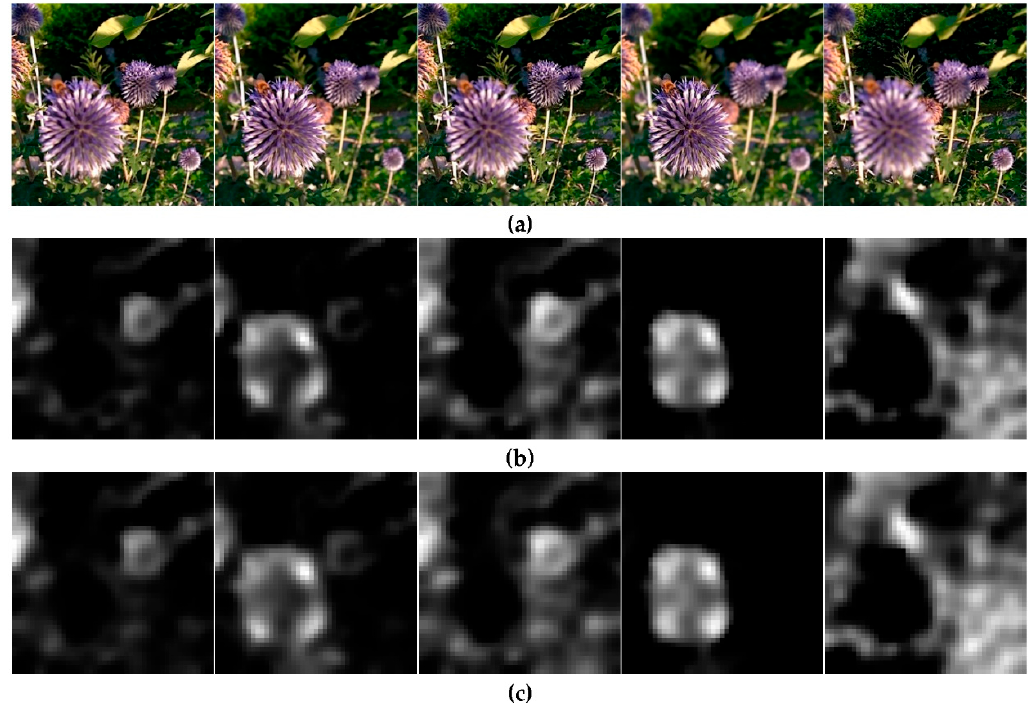
Figure 11. In-focused regions of the different focal stack images using SML and SUML—‘Flower’ dataset: ( a ) The input images of different focal lengths; ( b ) SML of stack images; and ( c ) SUML of stack images.